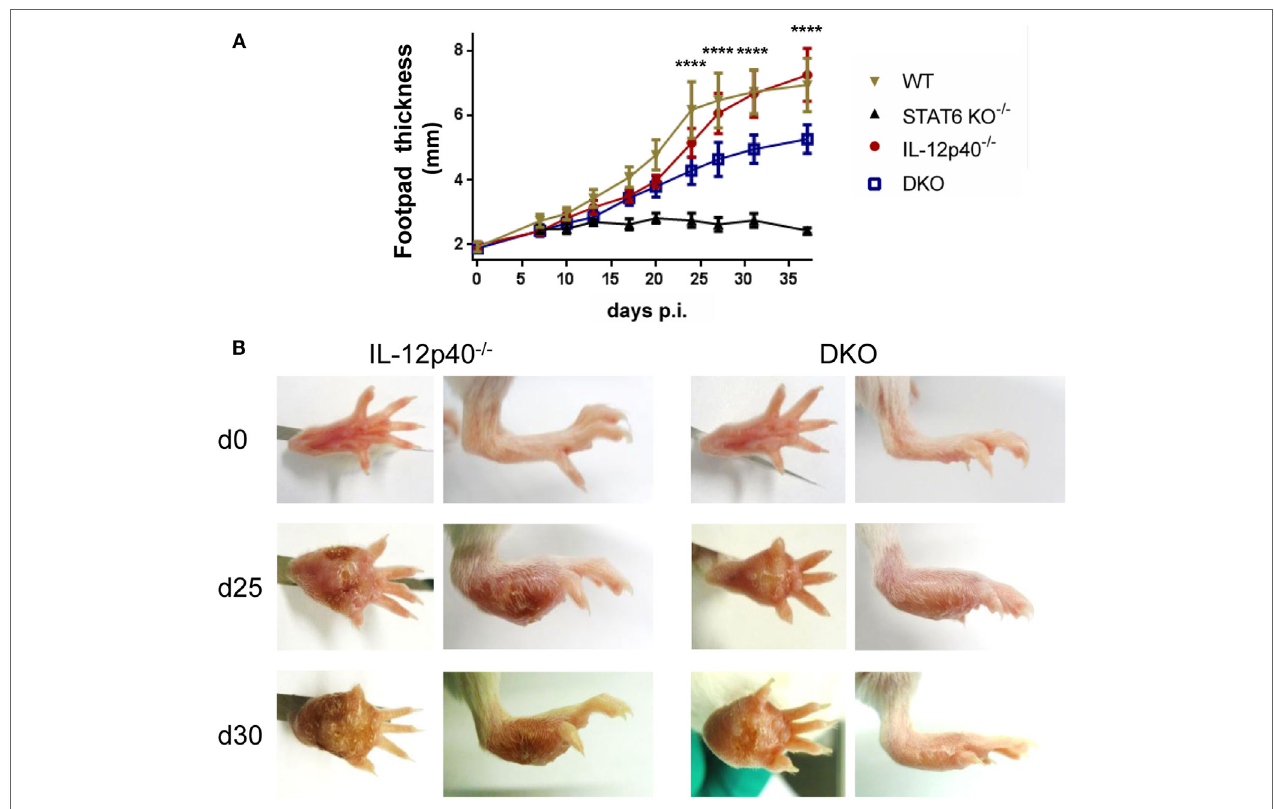
FigUre 1 | In the absence of IL-12p40 and STAT6 signaling, BALB/c mice display reduced footpad swelling. Footpad thickness measurements of naïve and Leishmania major -infected wild type (WT), IL-12p40 − / − , STAT6 − / − , and double knockout (DKO) BALB/c mice over the course of infection. (a) Footpad thickness (in millimeter) measured with a dial caliper at different days p . i and significant difference ( p -value) displayed between IL-12p40 − / − and DKO mice. (B) Front and side view of the footpads of uninfected and infected mice at d25 and d30 post-infection for IL-12p40 − / − and DKO BALB/c mice. Data represent five independent experiments with at least six footpads per group. Error bars are shown as SDs. * p < 0.05, ** p < 0.01, *** p < 0.001, **** p <